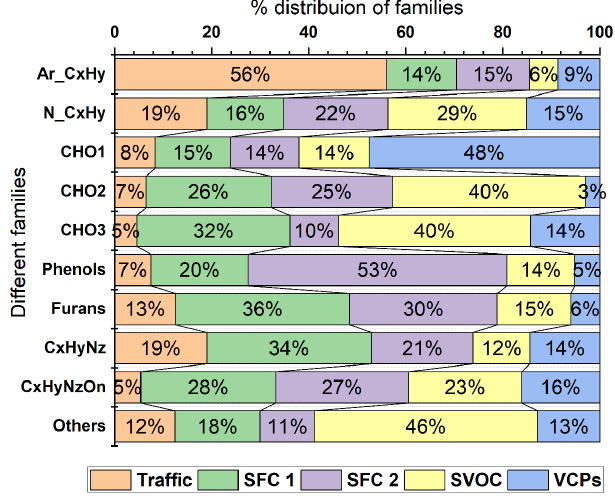
Figure 7. Relative contributions (%) of different families to the in- dividual